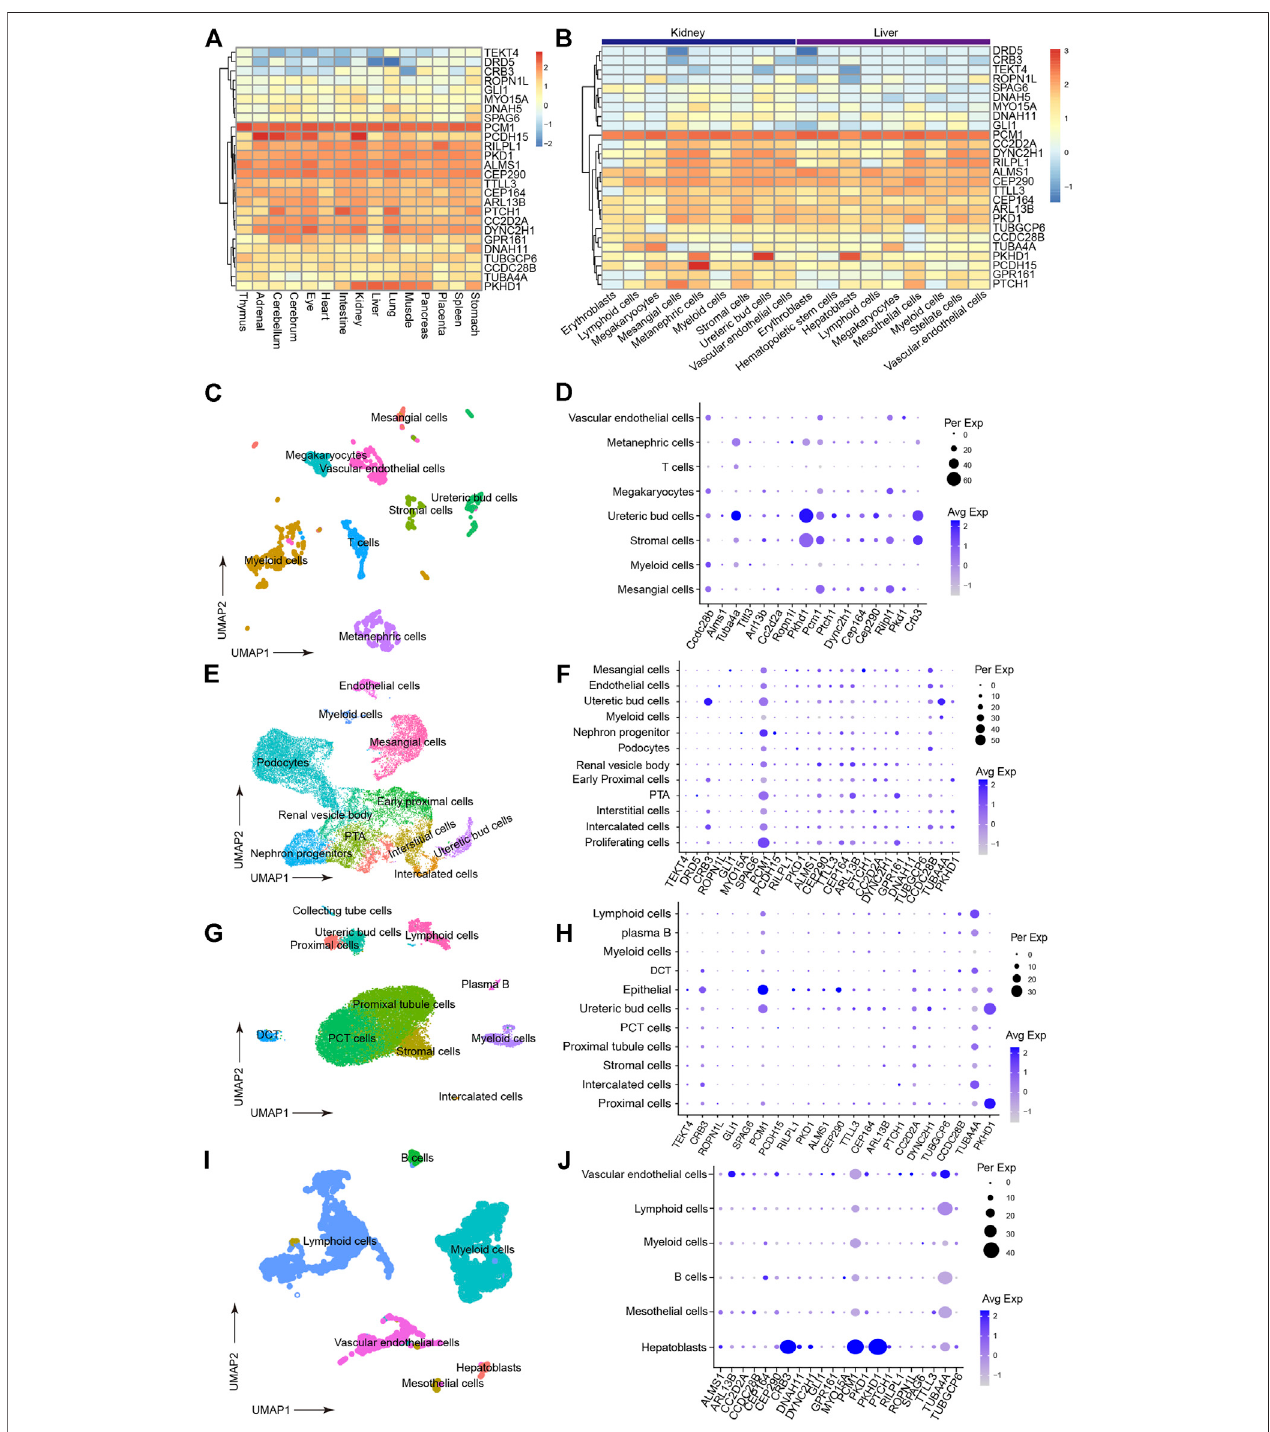
FIGURE 3 | PrioritizationofdetectedciliageneswithscRNA-seq. (A) Heatmapofdetectedciliageneexpressioninmultiplehumanfetalorgansusingdataunderaccession GSE156793.Geneexpressionhavebeenscaledwithnormalizedreadcountsforeachgene. (B) Heatmapofdetectedciliageneexpressionindifferentcelltypesfromhumanfetal kidney andliver tissues(fromGSE156793). Geneexpression havebeenscaled withnormalizedread countsforeachgene. (C) UMAPplotshowingtheclusteringofdifferentcell types in mouse kidneys (from GSE140023). (D) Dot plot of cilia genes in mouse kidney (from GSE140023). The expression inferred Pkhd1, Crb3 and Tuba4a had similar expressionpattern.Dotsizeindicatedpercentageofcellwhichexpressedgeneofinterestandcolorindicatedexpressionlevel. (E) UMAPplotshowingtheclusteringofdifferentcell types in human fetal kidney (from GSE114530). (F) Dot plot re fl ecting the cell type expression patterns of the detected cilia genes (from GSE114530). This result supported that PKHD1andCRB3hadsimilarexpressionpattern. (G) UMAPplotshowingtheclusteringofdifferentcelltypesinhumanfetalkidney(fromGSE131685). (H) Dotplotre fl ectingthe celltypeexpressionpatternsofthedetectedciliagenes(fromGSE131685). (I) UMAPplotshowingtheclusteringofdifferentcelltypesintheadulthumanliver(fromGSE159929). (J) Dot plot re fl ecting the cell type expression patterns of the detected cilia genes (from GSE159929).